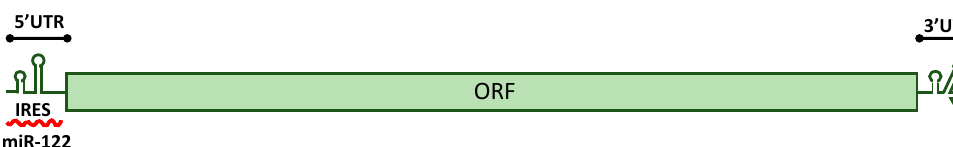
Figure 4. miR-122 and interaction with HCV RNA. HCV genome is a positive single-stranded RNA particle which encodes for a polyprotein processed into ten different proteins. miR-122 is essential for HCV replication. miR-122 binds the 5 ′ -UTR, the IRES region, protects against the degradation of HCV genome, and thus promotes HCV replication. IRES = Internal Ribosome Entry Site; 3 ′ -UTR = 3 ′ -Untranslated Transcribed Region; 5 ′ -UTR = 5 ′ -Untranslated Transcribed Region; ORF = Open Reading Frame.